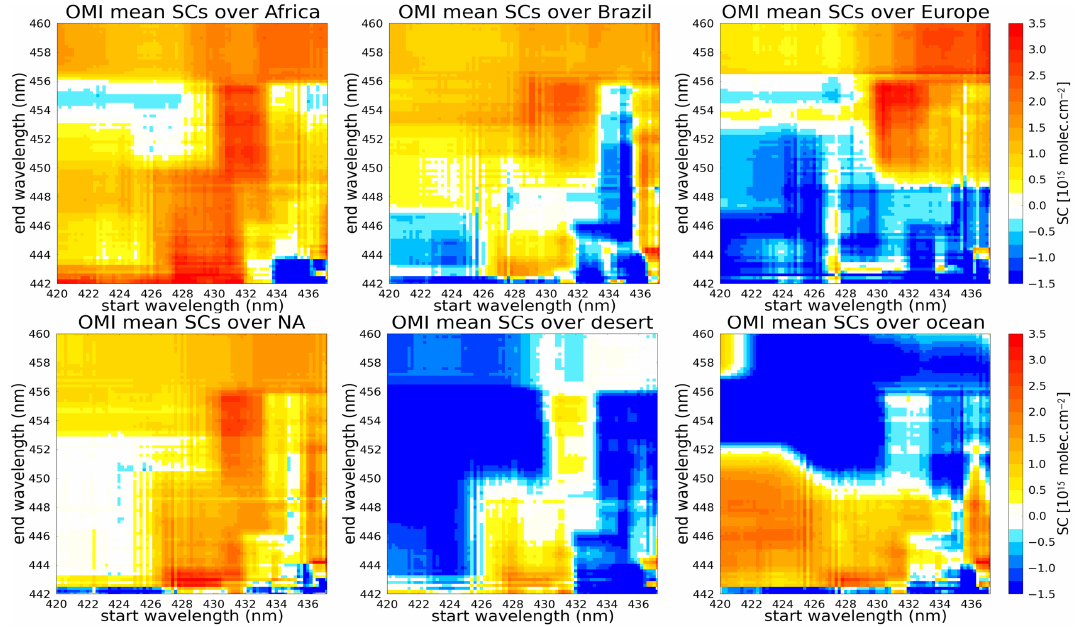
Figure 2. CHOCHO SC means retrieved over selected regions from OMI measurements for wavelength windows with start limits of 420– 437nm and end limits of 442–460nm, during different days on August 2007 (see Table